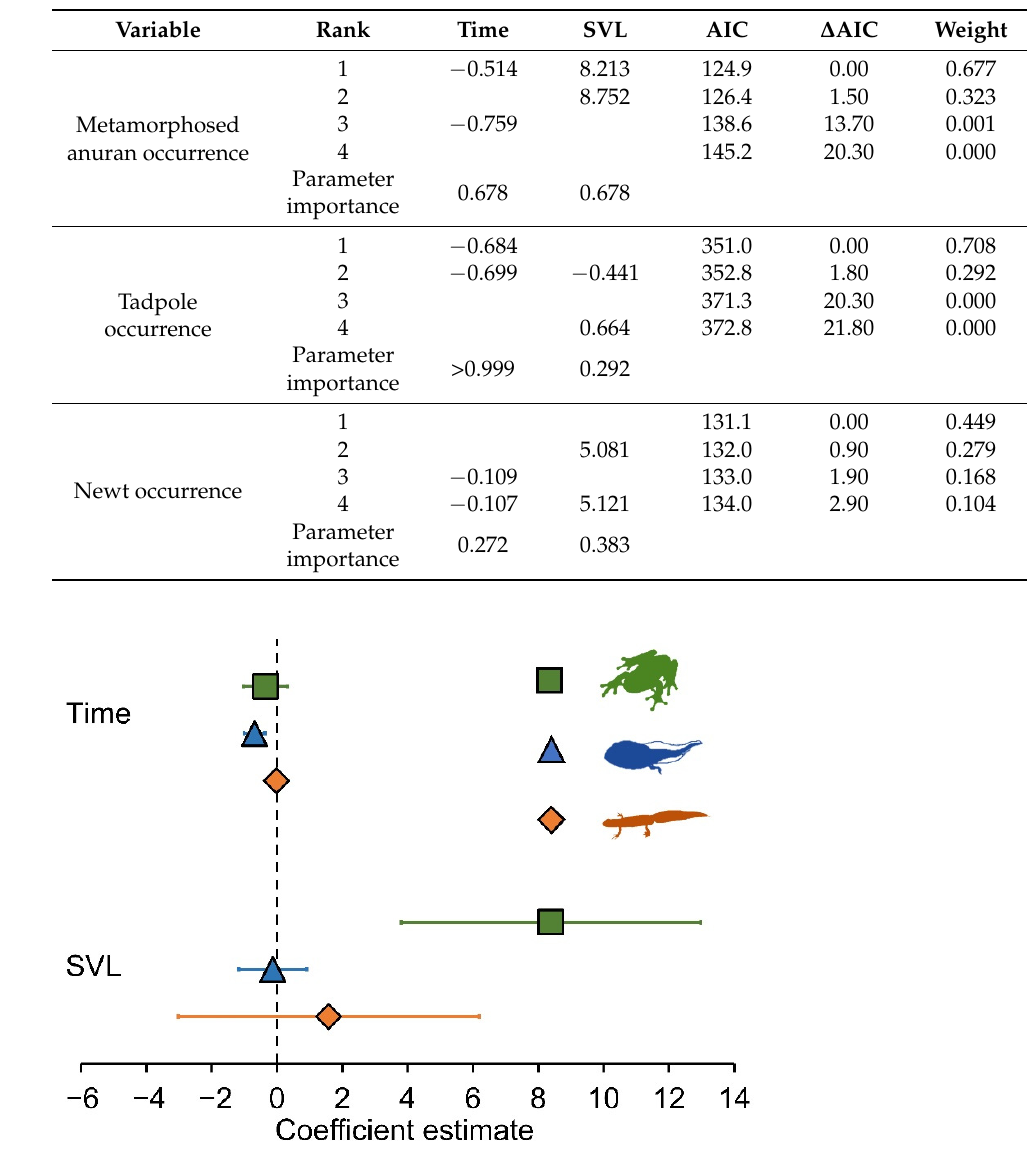
Figure 2. Effect of parameters in average GLMM models assessing amphibian occurrence in stomach contents of marsh frogs (estimates, 95% CI). Green lines and squares: metamorphosed anurans; blue lines and triangles: tadpoles; orange lines and diamonds: newts. Time: months (April to July); SVL (snout-vent length): body size of marsh frogs.